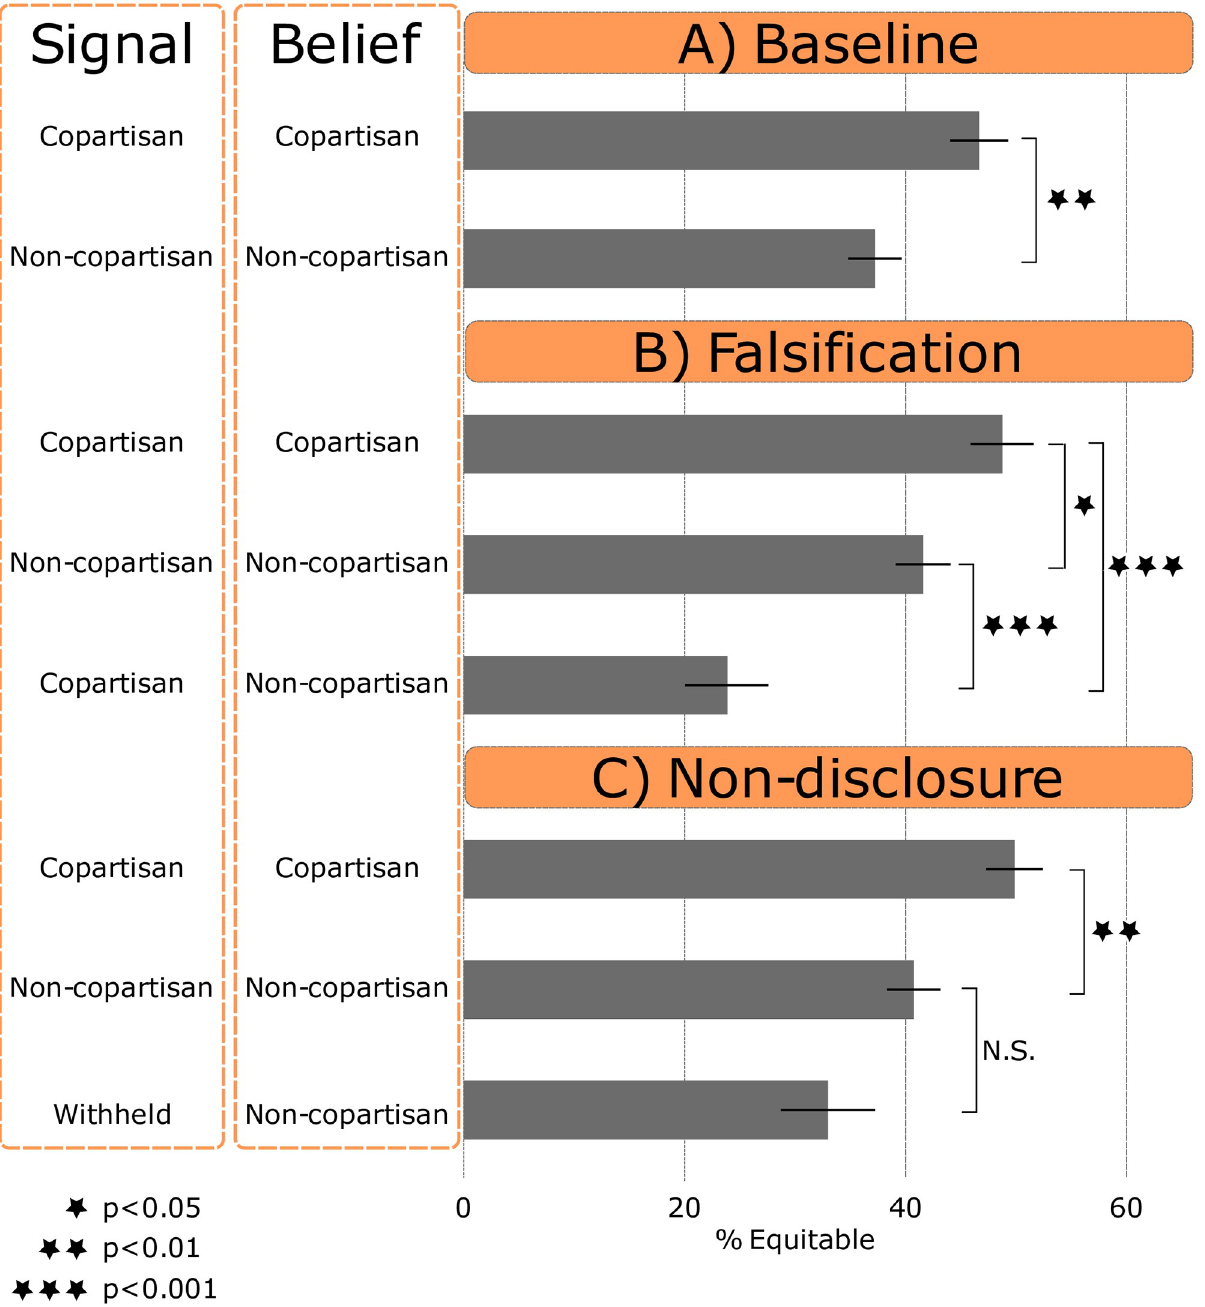
Fig 1. Share of equitable contributions by the identity signaled by partners and the identity believed by participants, across experimental conditions, p-values are based on two-sided